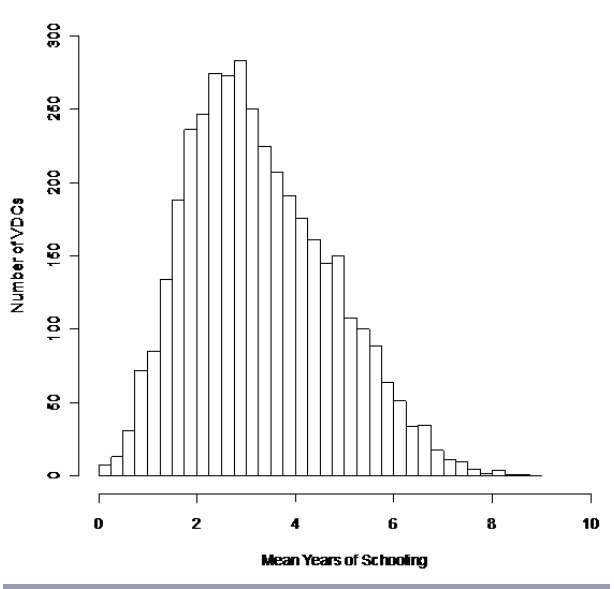
Fig. 2 . Distribution of mean years of schooling among youths aged 15 to 39 years in Village Development Committees (VDC) and municipalities in Nepal, 2001